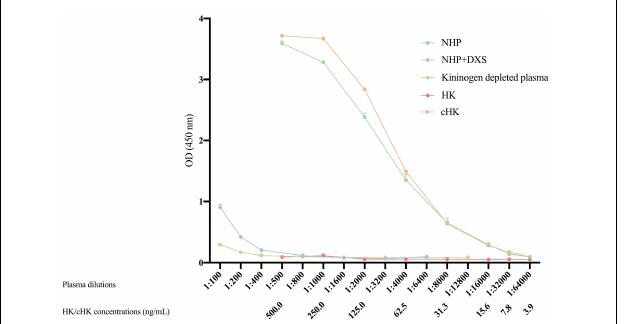
FIGURE 4 | Cleaved H-kininogen specific non-competitive sandwich ELISA. cHK levels were measured by the cHK specific non-competitive ELISA using monoclonal antibody (mAb) 19-20-3 as capture antibody and biotinylated mAb 19-31-18 as detection antibody. Levels of cHK were measured in normal human plasma (NHP) in vitro activated with dextran sulfate (NHP + DXS). For comparison, the cHK level was measured in NHP, purified cHK, and HK in twofold dilutions. The cHK signals are given as optical density (OD) at 450 nm. Error bars indicate mean and range of a double determination.